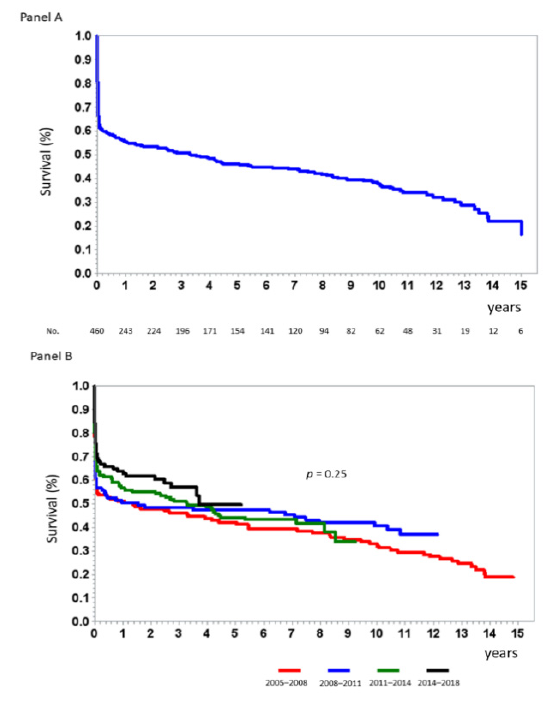
Figure 1. Kaplan-Meier curves showing the long-term survival rate of the ST-segment elevation acute myocardial infarction patients with cardiogenic shock enrolled in the study (Panel A ) and stratified according to quartiles of date of index hospitalization (Panel B ). p value by Log rank test.